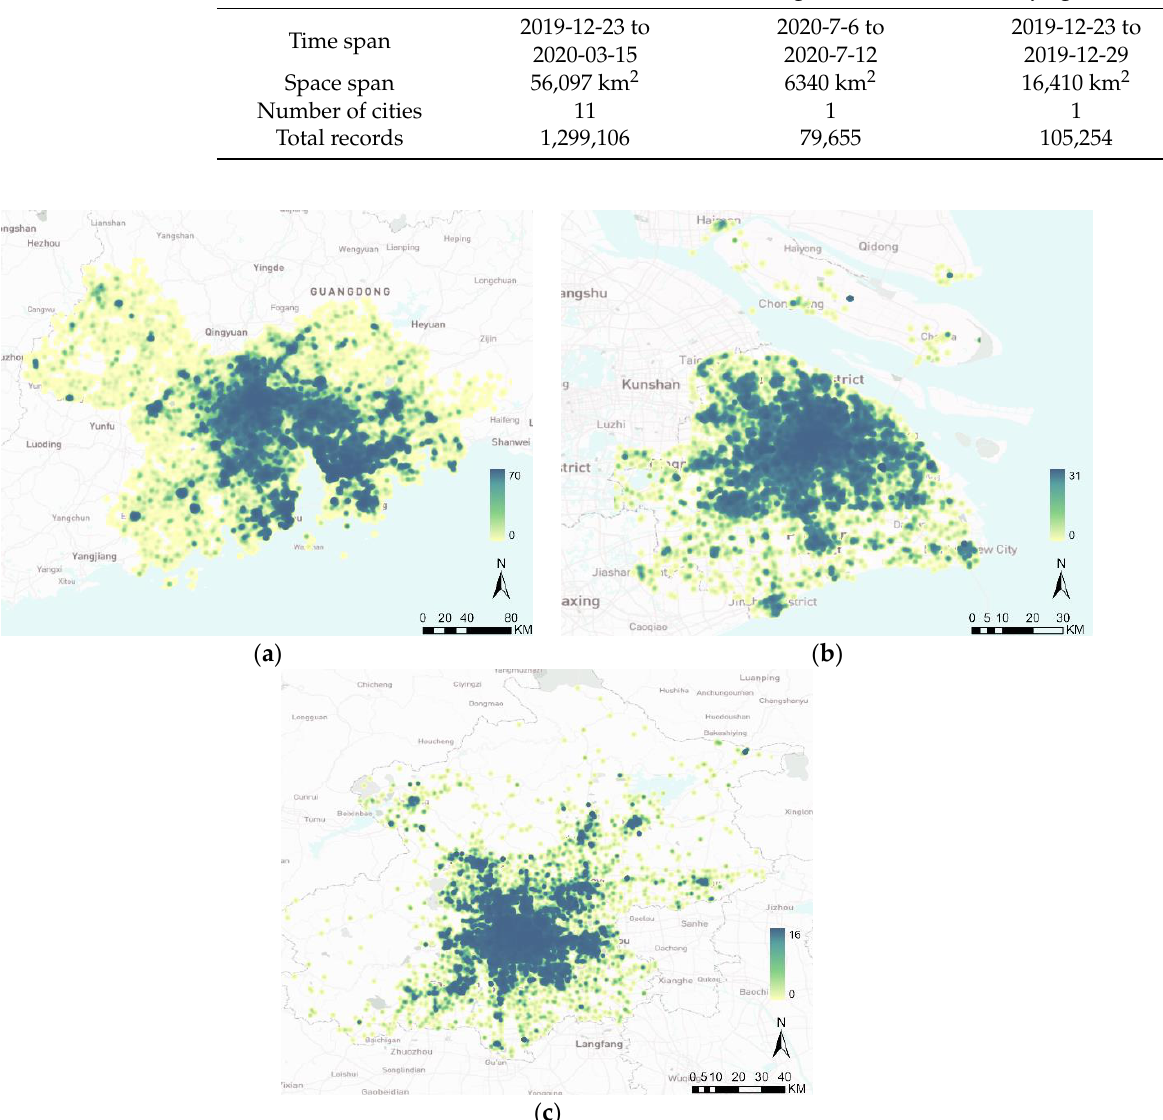
Table 1. Detailed information of the three datasets, showing the different spatio-temporal scales.